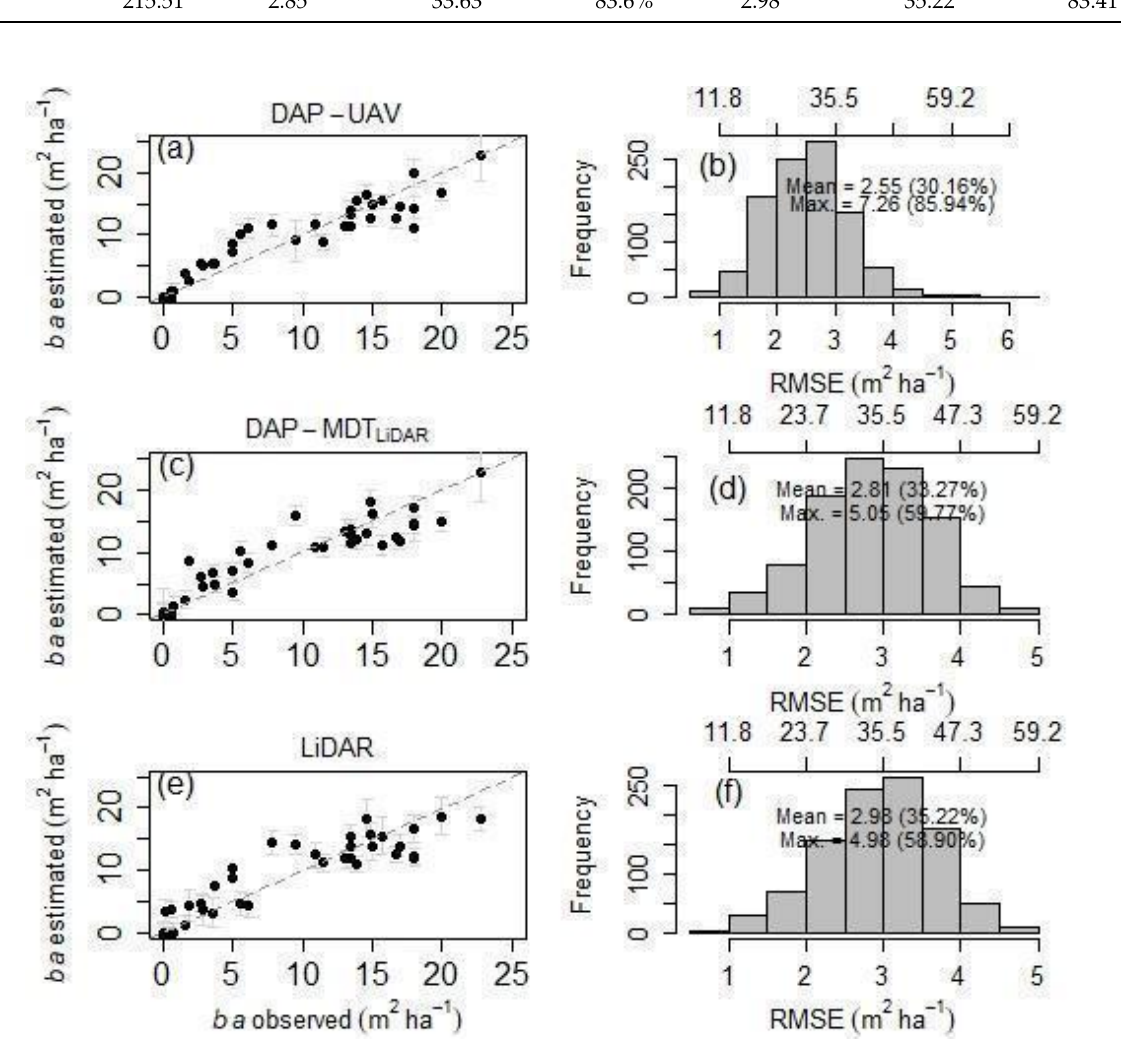
Figure 12. Scatter plots between the estimated and observed ba values of ( a ), ( c ), and ( e ) and the RMSE frequency histograms in the validation of models ( b ), ( d ), and ( f ) for DAP-UAV, DAP-DTM L- iDAR , and